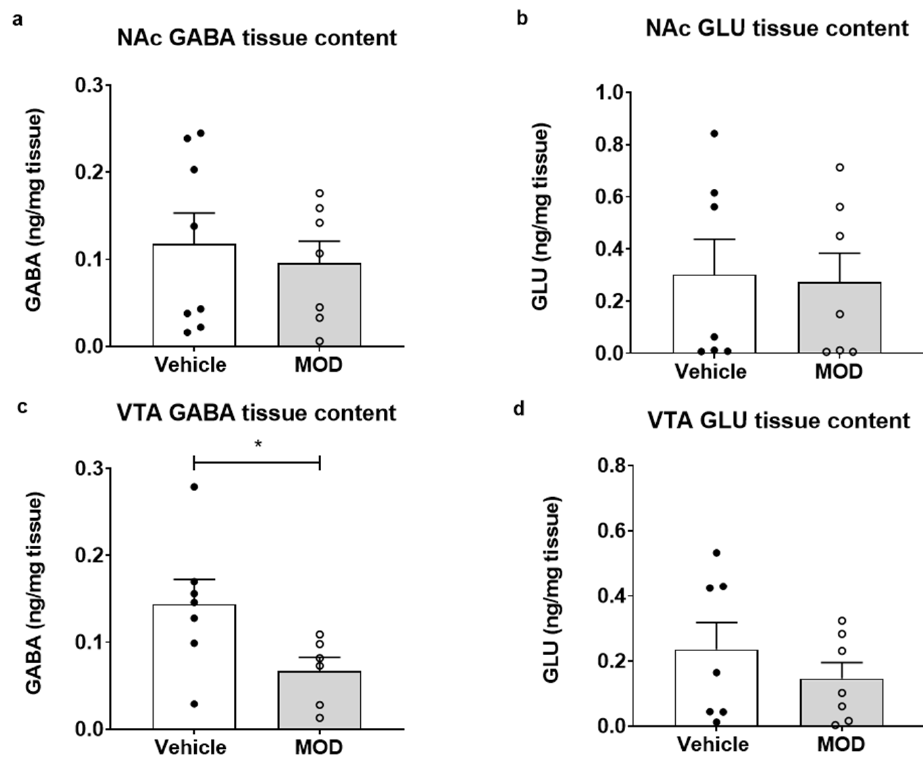
Figure 1. NAc and VTA glutamate (GLU) and GABA tissue content after 14 days of vehicle or MOD treatment in young rats. ( a ) NAc GABA tissue content, ( b ) NAc GLU tissue content, ( c ) VTA GABA tissue content and ( d ) VTA GLU tissue content. Data are presented as the mean ± SEM for NAc measurements: vehicle n = 8 and modafinil n = 7. For VTA measurement: n = 7 per group. * p < 0.05 .